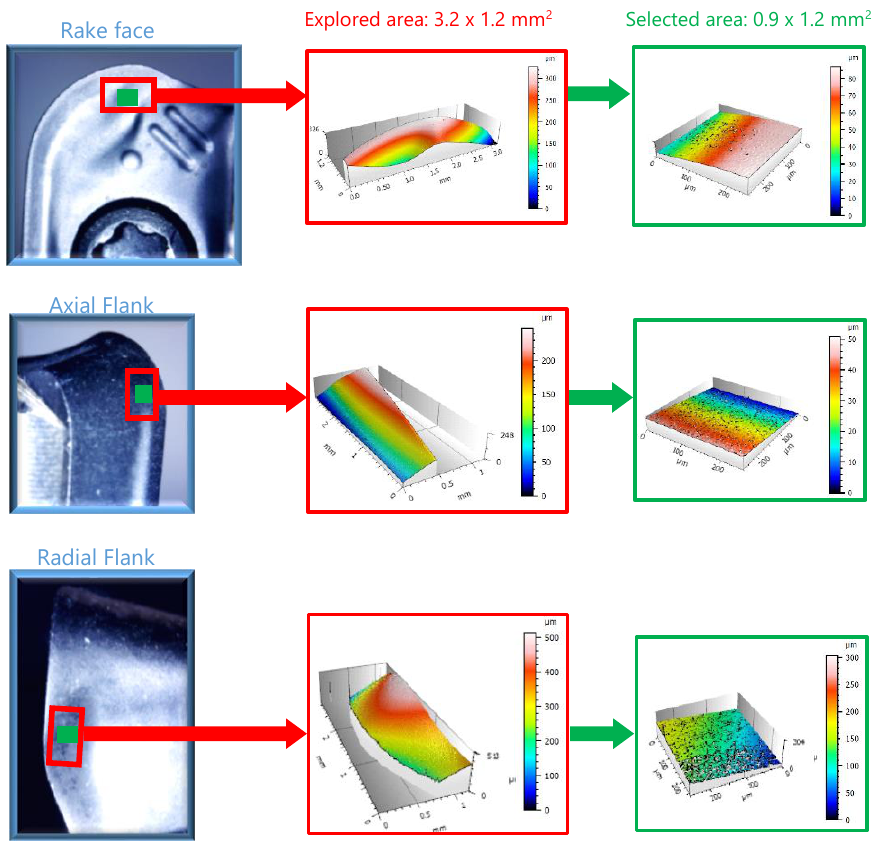
Figure 8. Areas of 3D surface measurement on inserts.